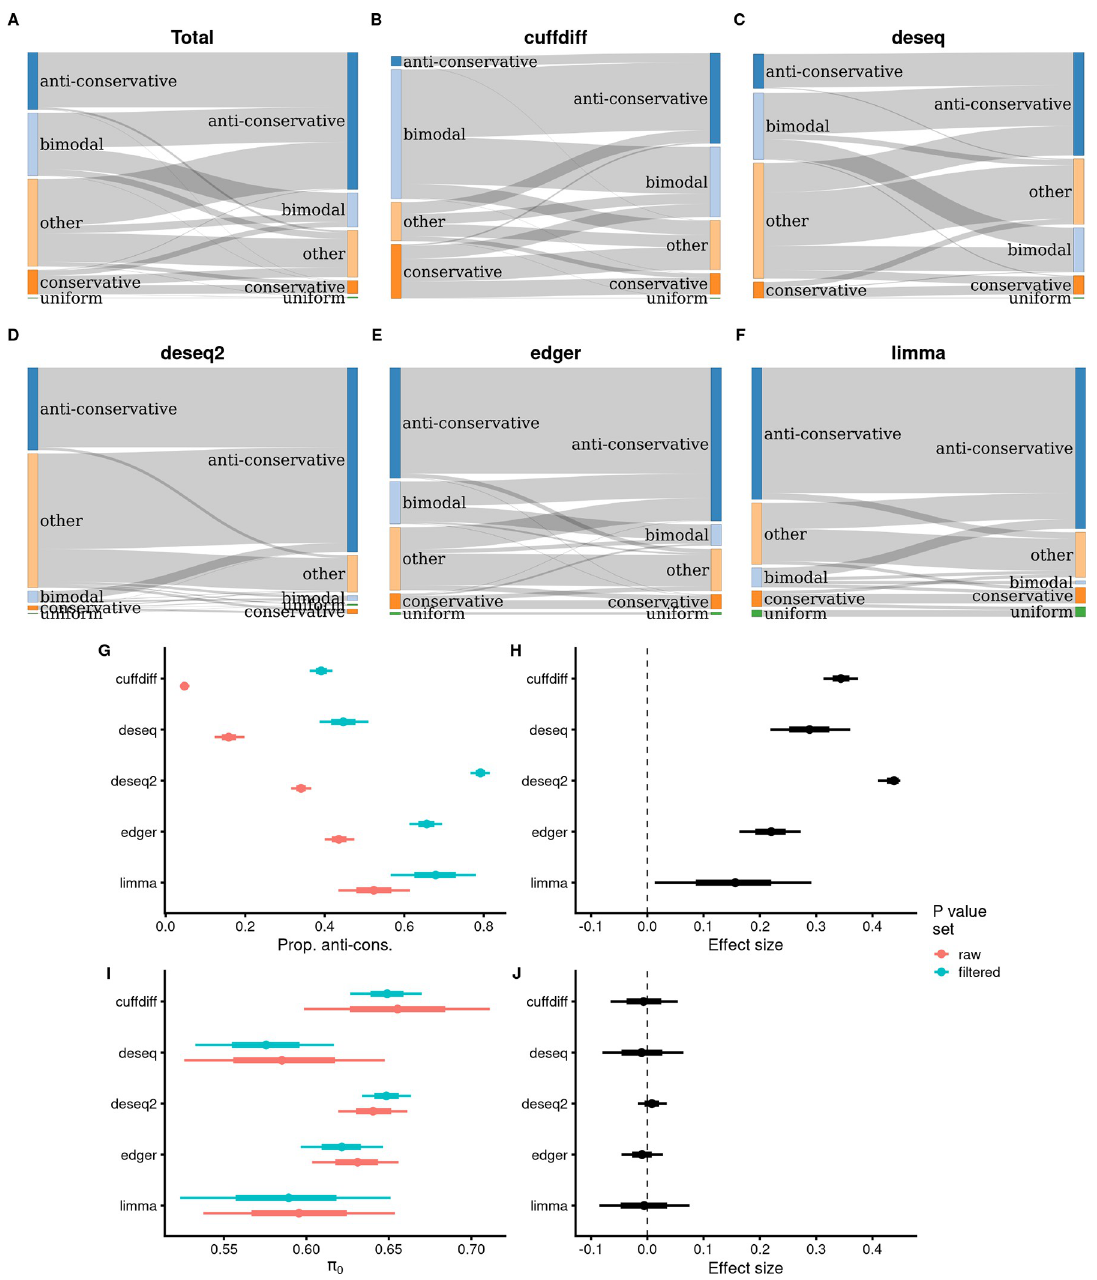
Fig 7. Removal of low-count features results in an increasing proportion of anti-conservative p -value histograms. (A-F) Sankey charts of transformation of p -value histogram shape. Ribbon size is linearly proportional to the number of p -value sets that change their distributional class. Only the 3,426 experiments that could be subjected to this treatment are depicted. ( A ) Complete data, N = 3,426. ( B ) The subset where the p -values were calculated with cuffdiff, N = 1,116. ( C ) The subset where the p -values were calculated with DESeq, N = 252. ( D ) The subset where the p -values were calculated with DESeq2, N = 1,114. ( E ) The subset where the p -values were calculated with edgeR, N = 515. ( F ) The subset where the p -values were calculated with limma, N = 73. ( G ) Posterior summaries of anti- conservative p -value histogram proportions in raw and filtered p -value sets. Filtered p -value data is from a Bernoulli model [anticons ~ de_tool], N = 3,426. The data files are in S13 Data and in S14 Data (for raw data). ( H ) Effect sizes in percentage points of low-count feature filtering to the proportion of anti-conservative p -value histograms. The data files are in S13 Data and in S14 Data (for raw data). ( I ) Posterior summaries of π 0 values of p -value histograms in raw and filtered p -value sets. Filtered p -value data is the p -value from the beta model [pi0 ~ de_tool], N = 2,042. The data files are in S15 Data and in S16 Data (for raw data). ( J ) Effect sizes in π 0 units (percentage points) of low-count feature filtering to π 0 . The data files are in S15 Data and in S16 Data (for raw data). The model object